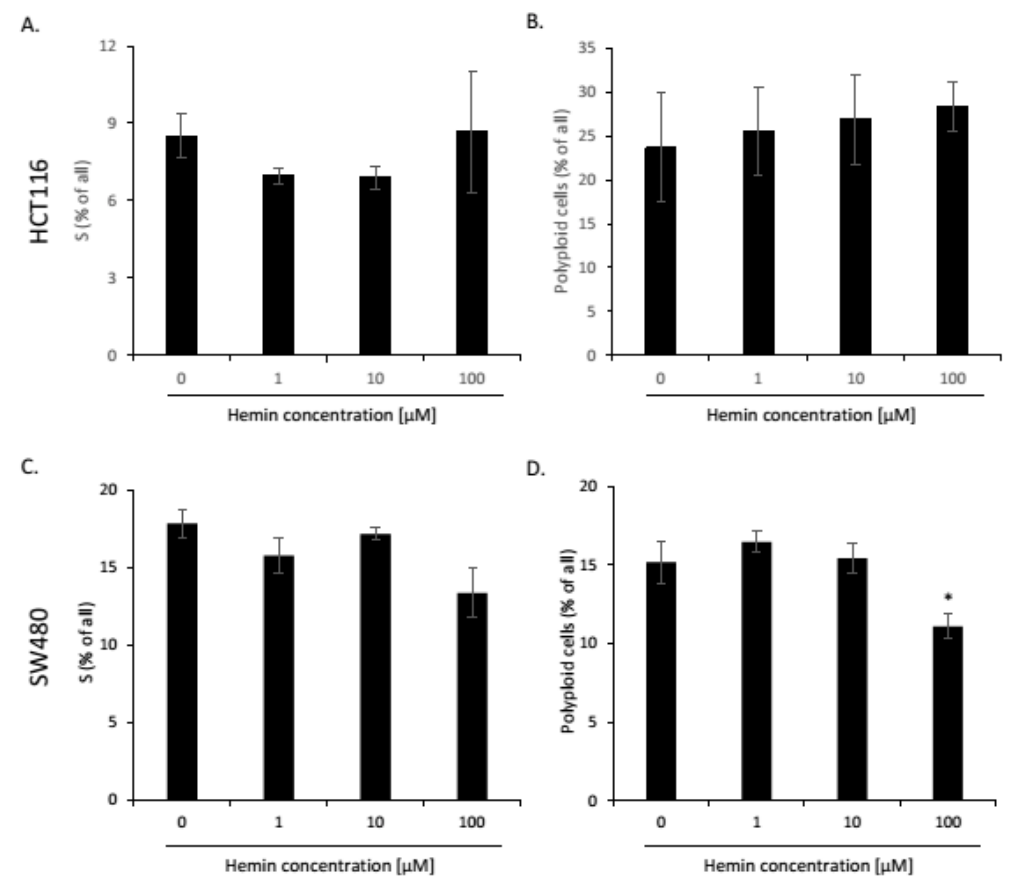
Figure A11. High hemin concentration slightly affects the distribution of HCT116 and SW480 cells in the S and polyploid phases of the cell cycle. HCT116 and SW480 cells were subjected to 2.5 µM of IRINO and 1, 10, or 100 µM of hemin. After 24 h, the medium was changed and the cells were cultured in a drug-free medium for 4 days. Quantification of the percentage of cells in the S phase in HCT116 ( A ) and SW480 cells ( C ). Quantification of the percentage of polyploid HCT116 ( B ) and SW480 cells ( D ). * p < 0.05.